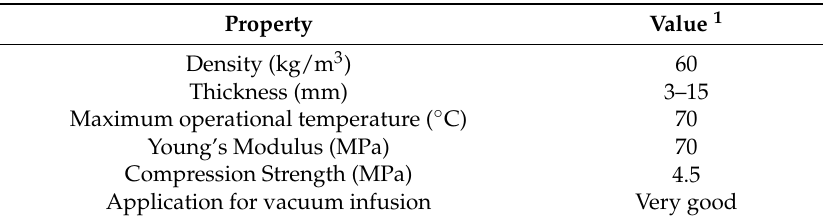
Table 3. PVC foam core for H2 components.